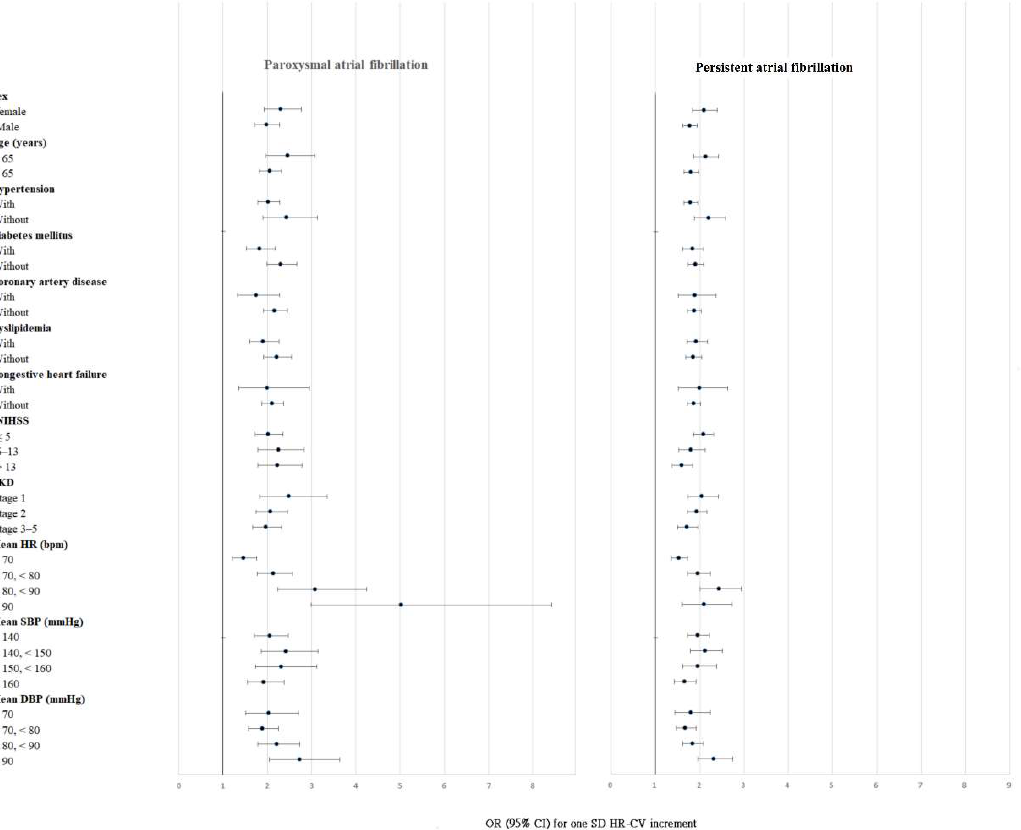
Figure 4. Subgroup analyses of paroxysmal and persistent atrial fibrillation per standard deviation of HR-CV increments. Abbreviations: HR-CV, coefficient of variation in heart rate; eNIHSS, esti- mated National Institutes of Health Stroke Scale; CKD, chronic kidney disease; HR, heart rate; SBP, systolic blood pressure; DBP, diastolic blood pressure; OR, odds ratio; CI, confidence interval; SD, standard deviation.